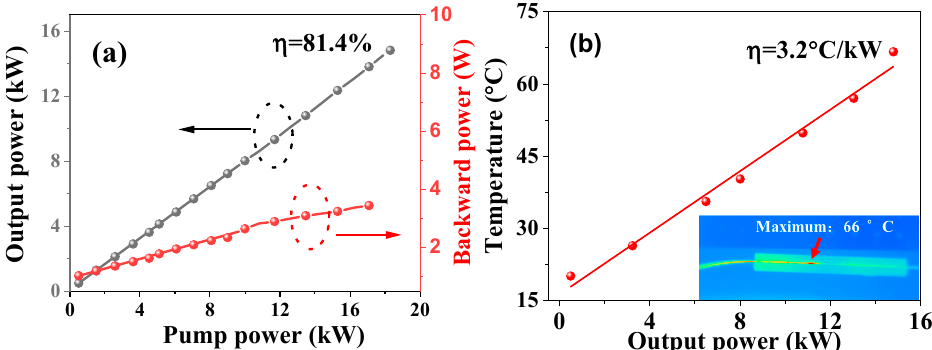
Figure 8. ( a ) The output power and efficiency results of the amplifier; ( b ) the temperature results of the amplifier.